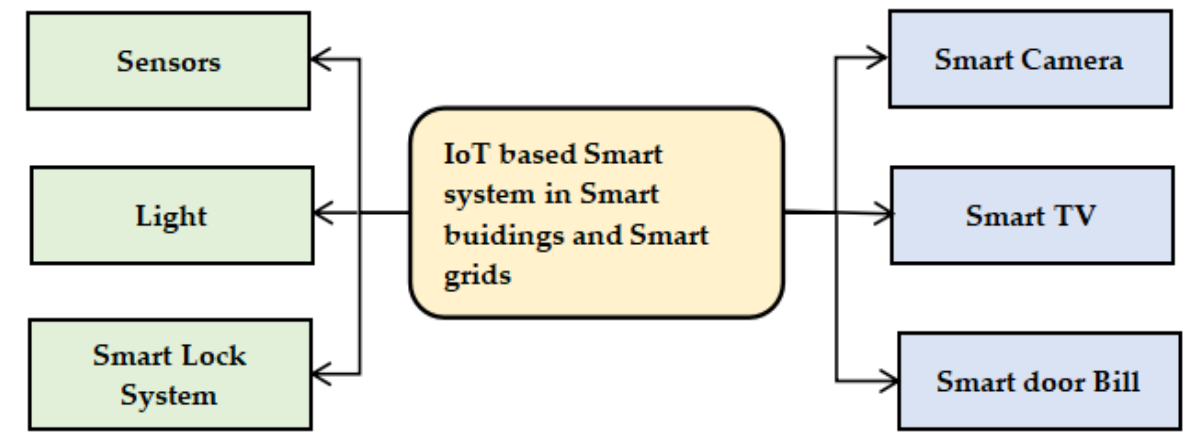
Figure 2. IoT-based smart buildings and grid systems [25].